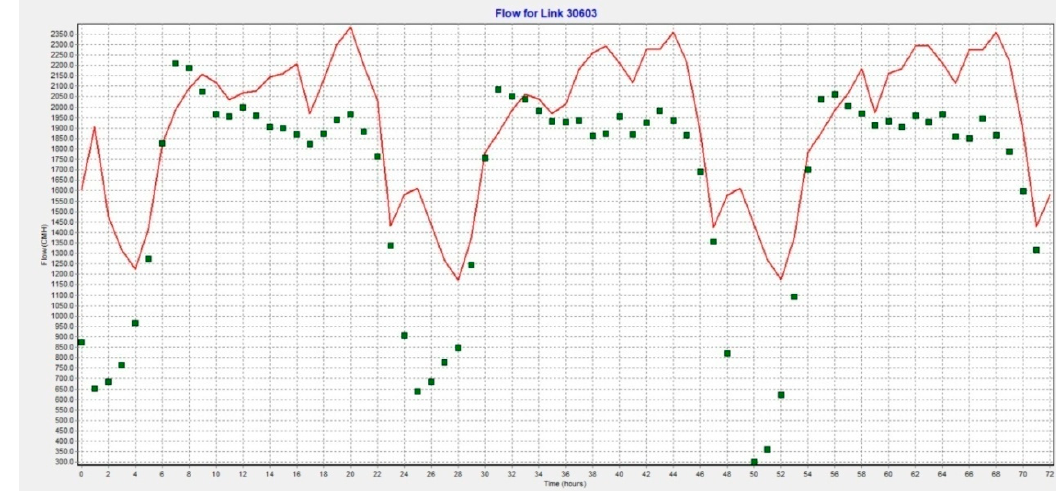
Figure 8. Results of Scenario III for Tanks E, east direction.